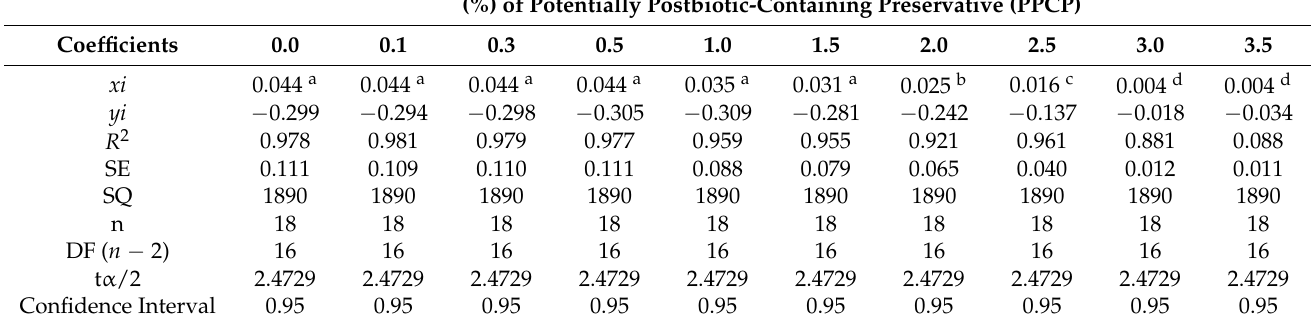
Table 2. Linear regression parameters of microbial growth.